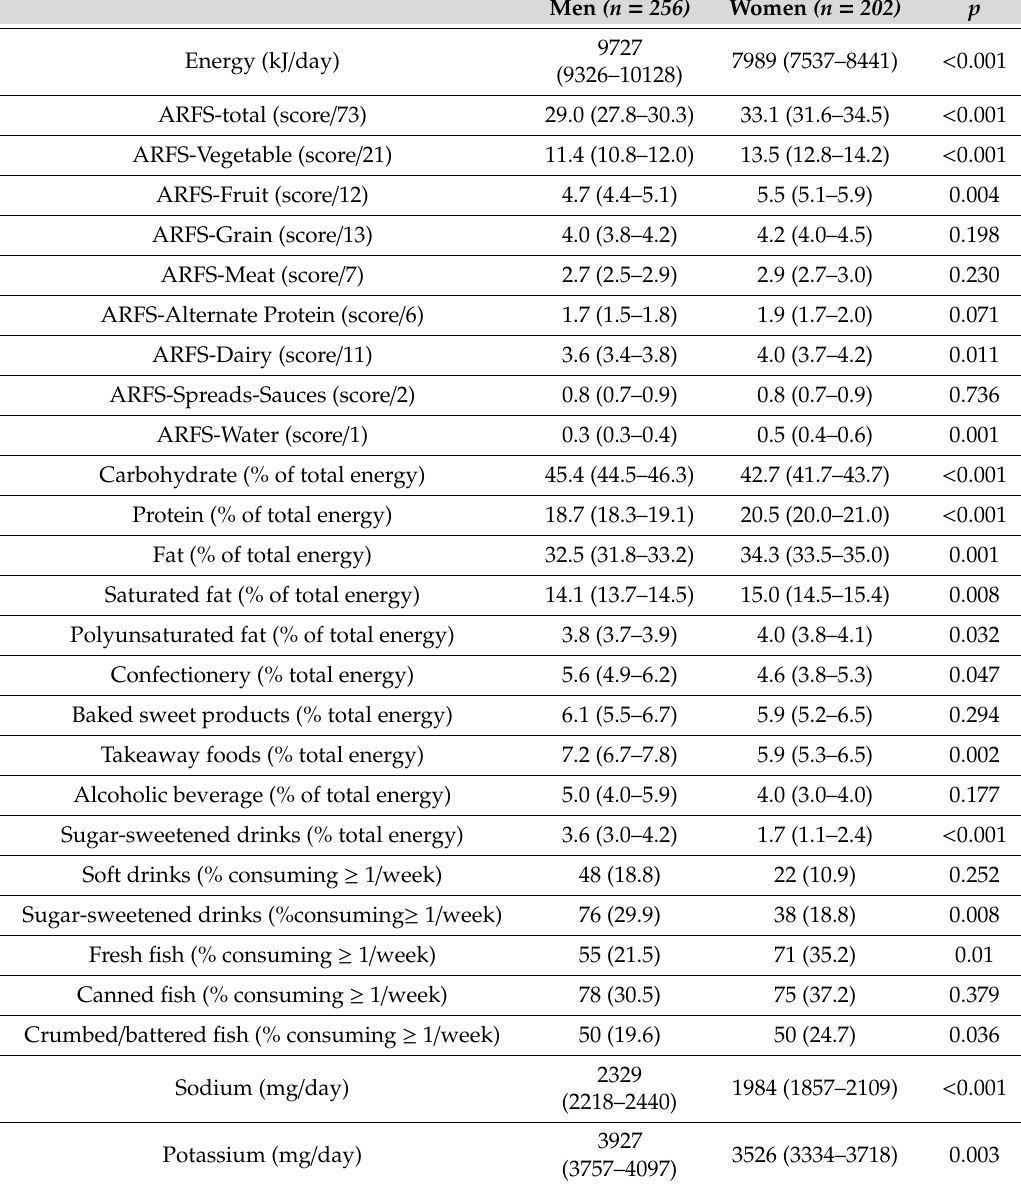
Table 2. Dietary characteristics for men and